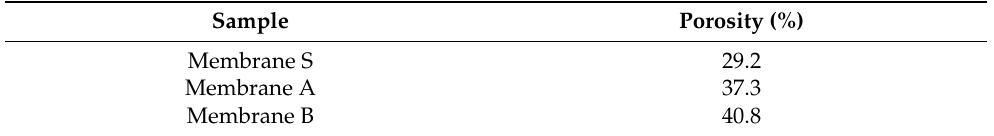
Table 3. The values of porosity of γ -Al 2 O 3 membranes: membrane S (without the addition of PVA); membrane A (addition of PVA after peptization); and membrane B (addition of PVA before